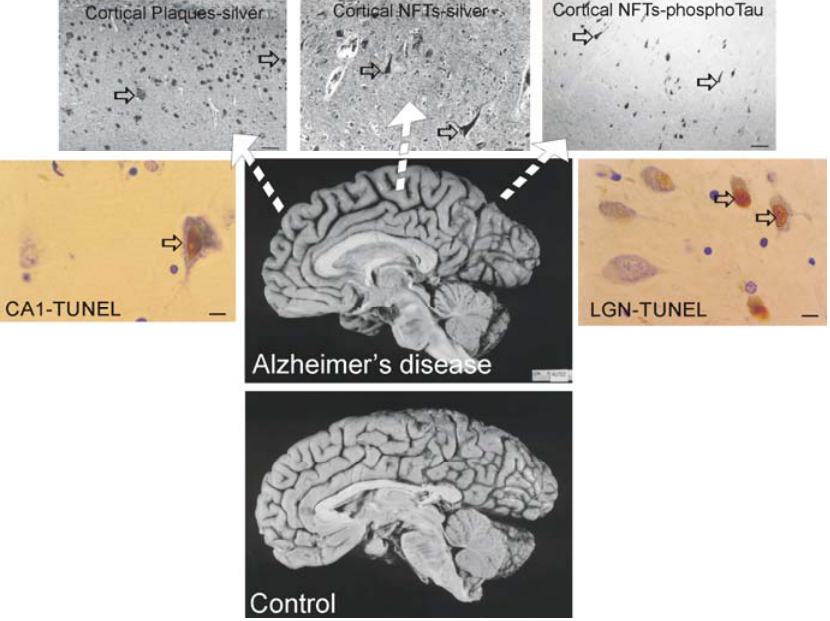
Figure 3. Brain atrophy and neurodegeneration in people with AD. Midsagittal views (center pictures) of the brains from an 85-year-old individual with AD and an 86-year-old normal control individual. The microscopic neuropathological hallmarks of AD are senile plaques (scale bar = 200 μ m), neurofibrillary tangles (NFTs, scale bar = 50 μ m.), and neuronal cell death determined by transferase-mediated biotin-dUTP nick-end labeling (TUNEL, brown nuclear staining, open arrows, scale bars = 10 μ m) as seen in the hippocampus CA1 and in subcortical regions such as the thalamic lateral geniculate nucleus